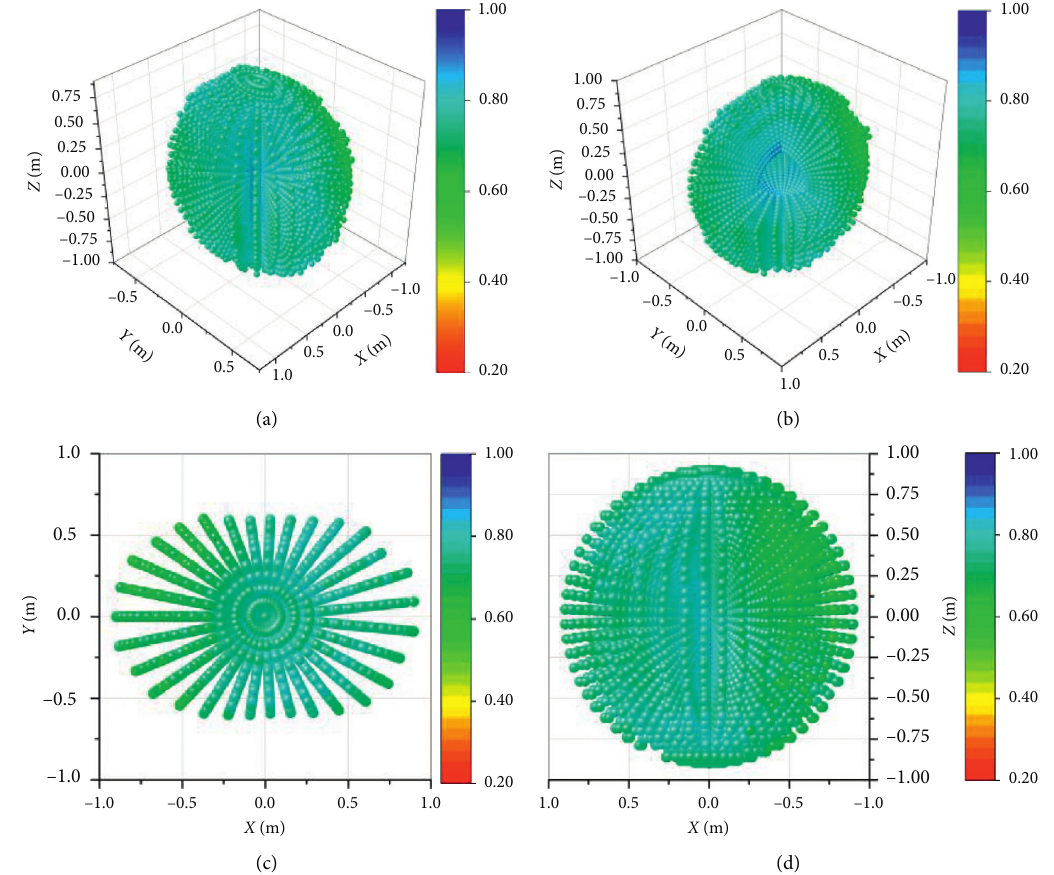
Figure 10: TOSM of the system in the workspace under the acceleration condition. (a) Axonometric view. (b) Section view. (c) X - Y plane. (d) X - Z